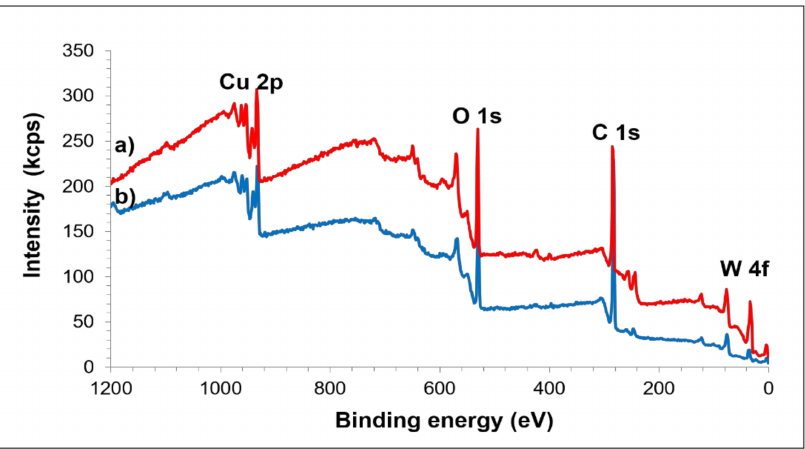
Figure 9. XPS wide scan spectra of the ( a ) sintered unmilled Cu-W-C mixture and ( b ) Cu-W-C sintered composite milled at 40